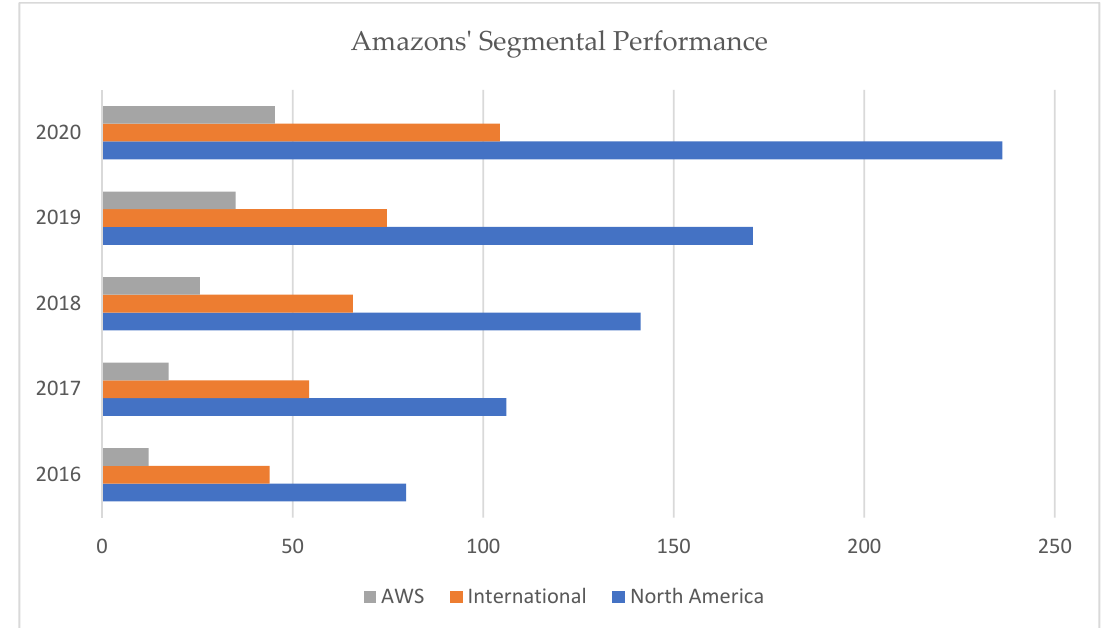
Figure 6. Amazon’s performance by segment.